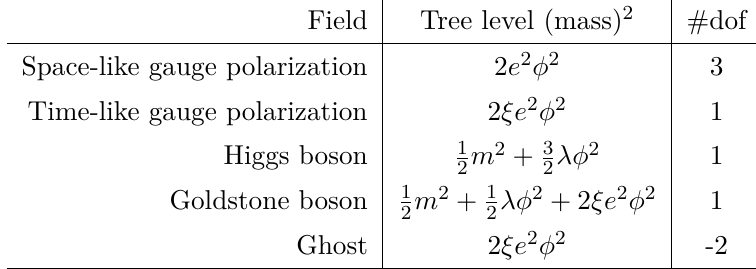
Table 1. The tree level masses and the number of degrees of freedom of the fields